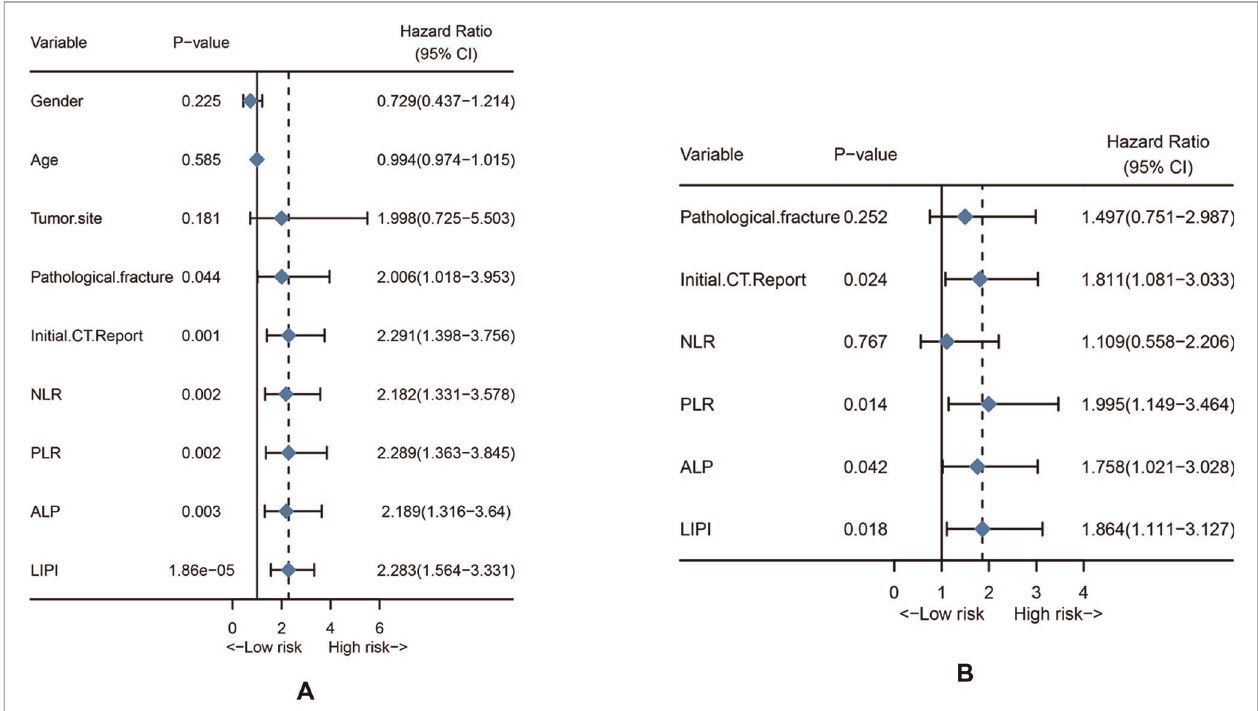
FIGURE 3 | Univariate analysis and multivariate analysis. ( A ) Univariate analysis of clinical features and hematological factors. ( B ) Multivariate analysis of signi fi cant clinical factors and hematological